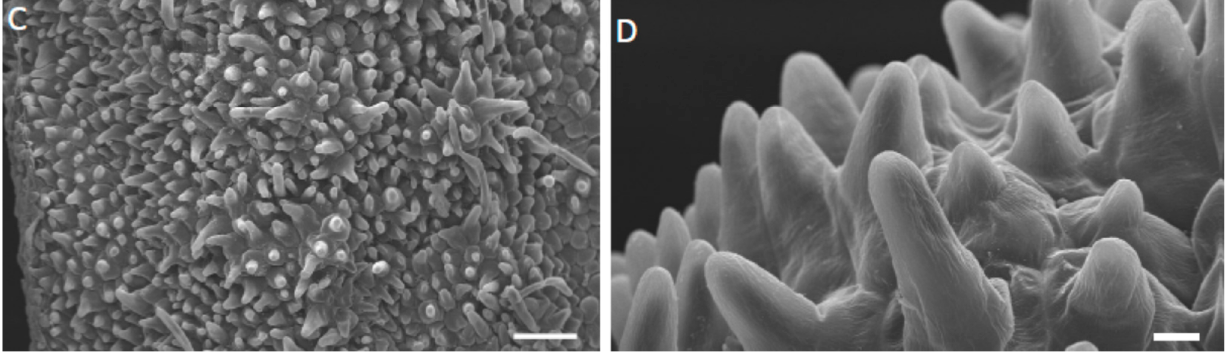
Figure 5. ( A – D ). Adaxial surface of the labellum of M. weberbaueri , SEM. ( A ). Central callus and marginal regions of labellum with scattered trichomes. ( B ). Multicellular, relatively long trichomes from the callus region. ( C ). Conical papillae and shorter trichomes from the apical part of the labellum. ( D ). Detail of conical papillae showing intact, smooth cuticle. Scale bars = 200 µm, 30 µm, 100 µm, 10 µm, respectively. Ca = callus.